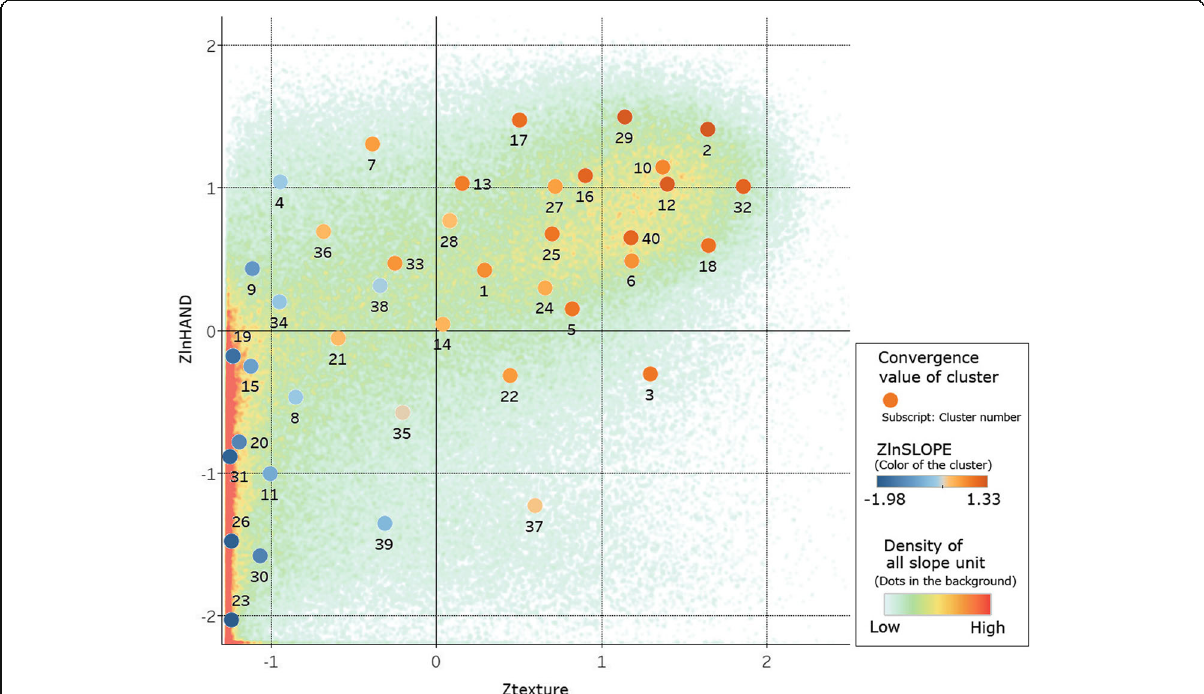
Fig. 8 Scatter plots of the convergence values for 40 clusters. The scatter plots of Z lnHAND and Z TEXTURE , where Z lnSLOPE is represented by the color of the dots. The background gradient is a plot of the average value for each terrain unit expressed as a density